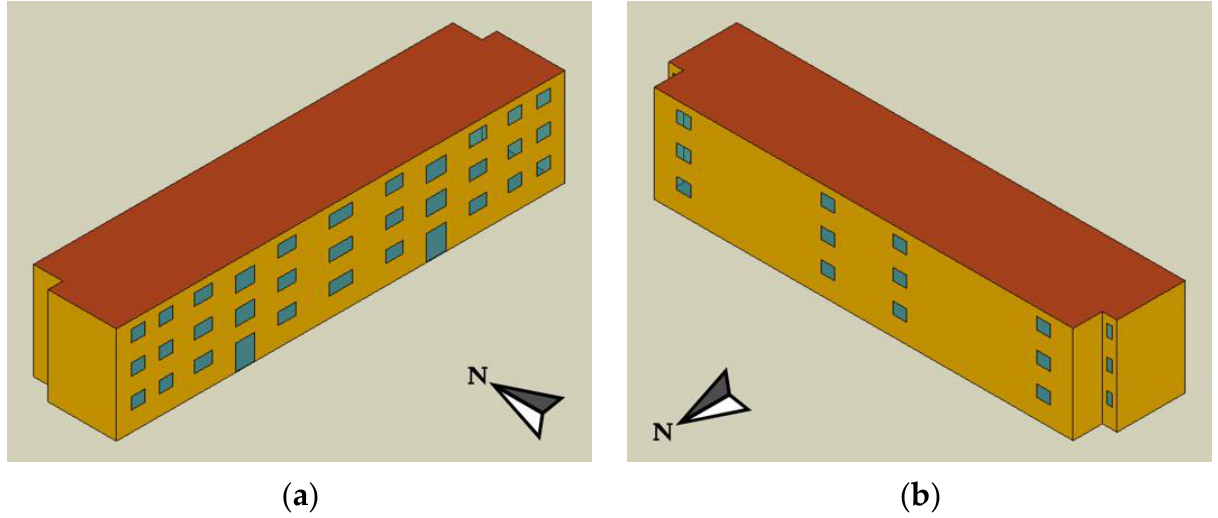
Figure 11. Office building modeled in SketchUp 3D: ( a ) south view; ( b ) north view. The same typical three-story office building is investigated upon, varying the insula- tion layer thickness on the south facade and the typology of second-skin material, for a total of eight case studies. Table 3 summarizes the eight simulation cases investigated in this work. In particular, this table reports the reference case (Case 0) without the second-skin (Figure 12a) and seven refurbishment case studies with the OVF system (Figure 12b) upon varying the second-skin material. These cases